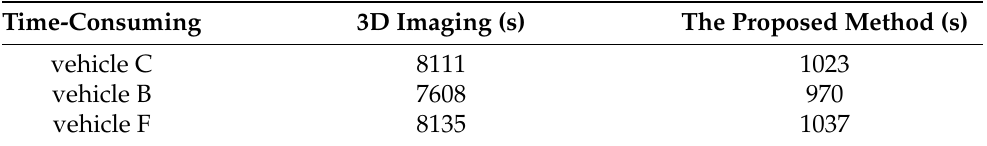
Table 4. Time-consuming comparison between 3D BP imaging and the proposed